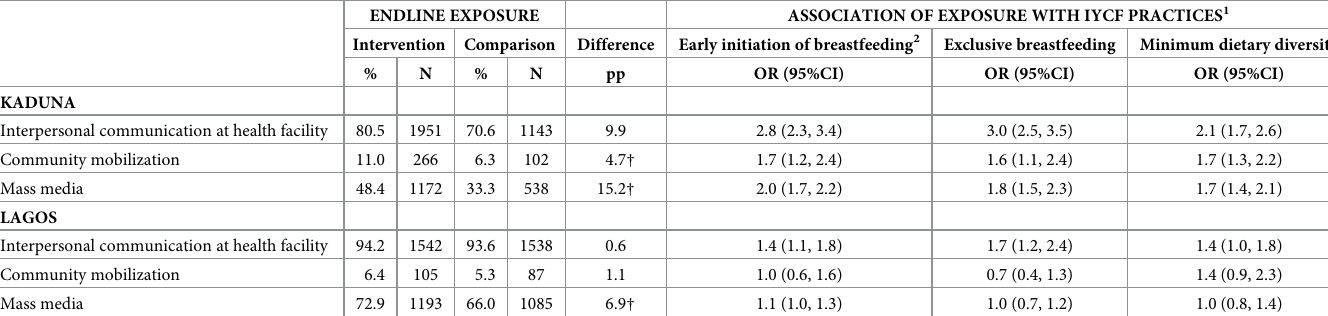
Table 4. Mothers’ exposure to Alive & Thrive intervention components and association of exposure with IYCF practices, by state. ENDLINE